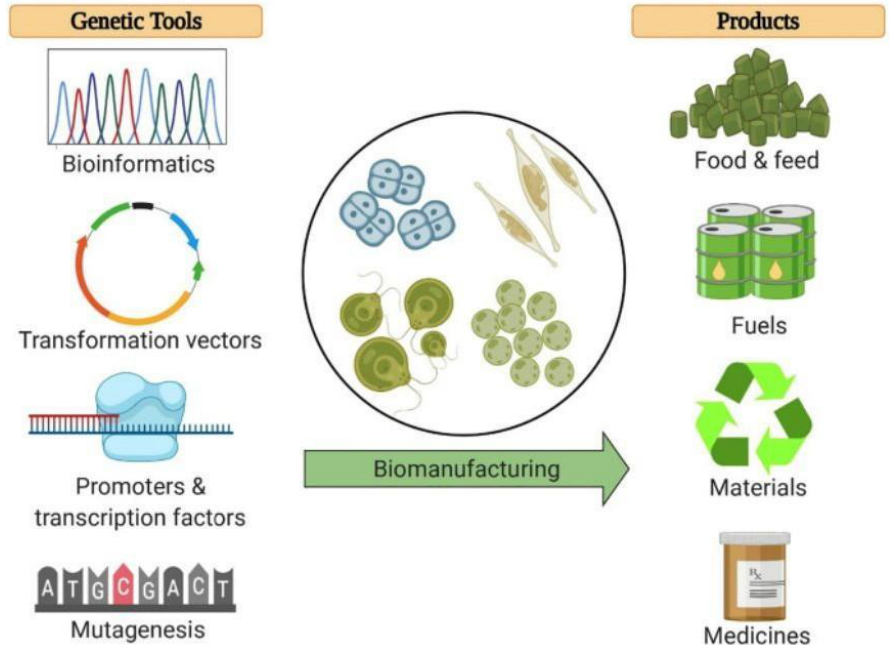
Figure 2. Genetic tools to develop microalgae as a platform for the biomanufacturing of commercial products. Bioinformatic algorithms are used to analyze algal genome sequences, resulting in codon optimization and motif discovery techniques that allow the design of strong expression vectors for the genetic transformation of algae strains. Regulatory elements, such as promoters and transcription factors, allow recombinant gene expression and manipulation of metabolic pathways to obtain products of interest. Random mutagenesis and genome shuffling can further drive the algal pro- duction strains toward desired phenotypes. These tools are being utilized to explore the industrial production of foods, fuels, materials, and medicines from microalgae. Reprinted with permission from ref. [155]. Copyright 2021 Elsevier.